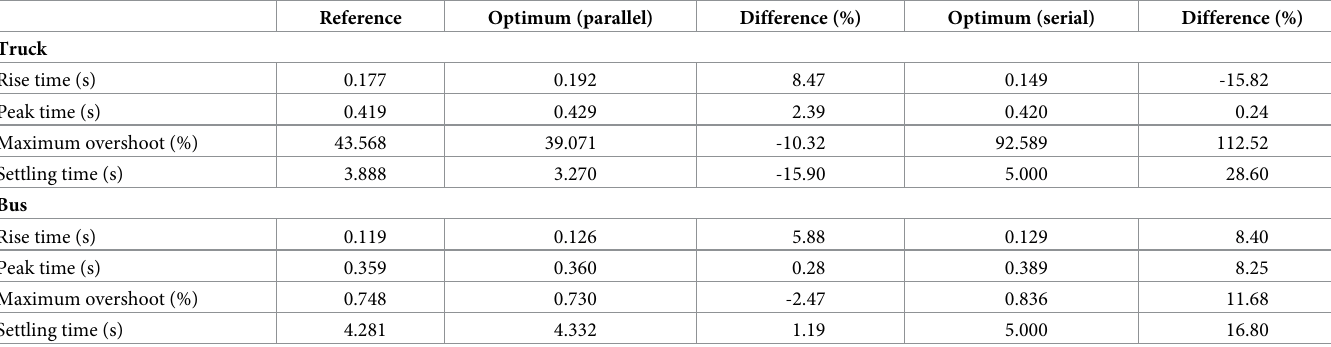
Table 3. Transient response characteristics of heavy vehicles with inerter due to step road